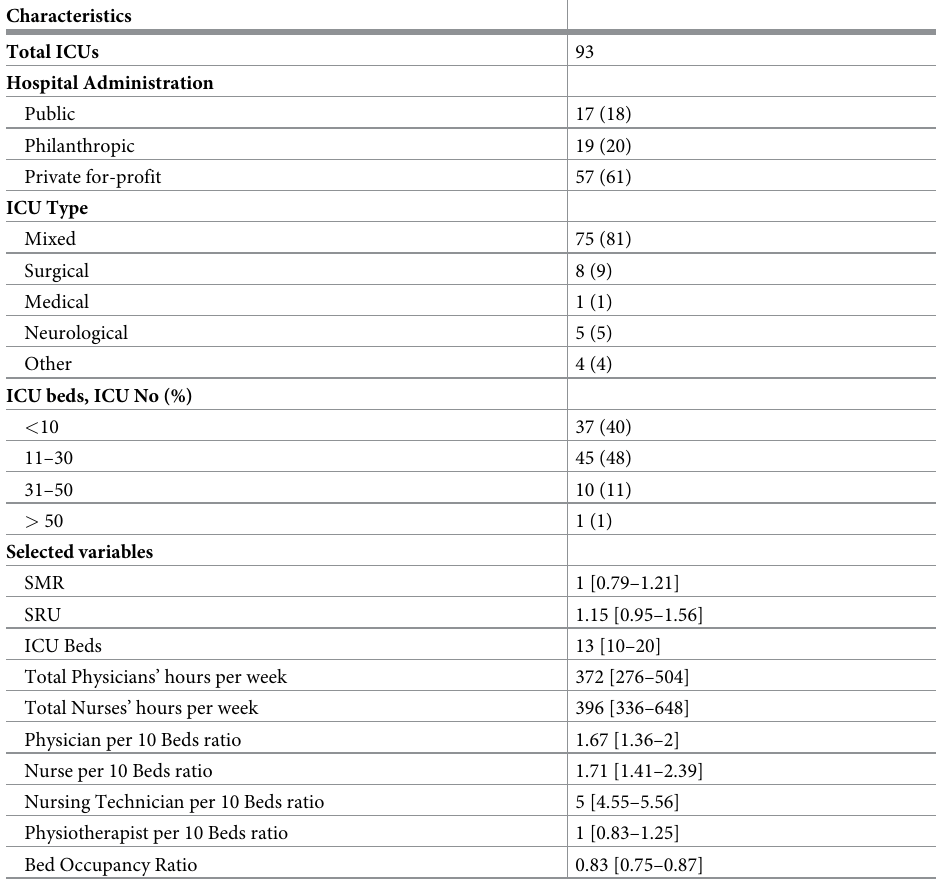
Table 3. Characteristics of the 93 analyzed